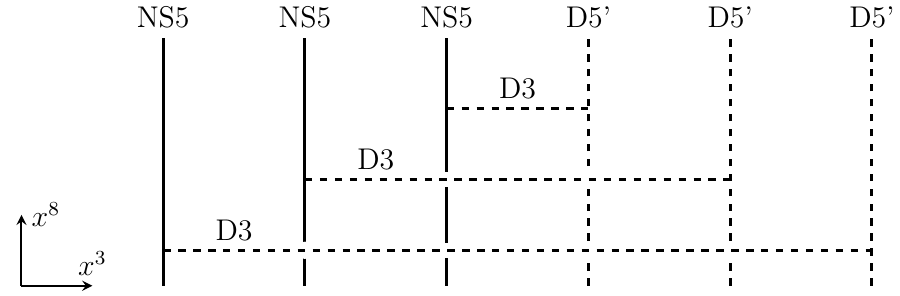
Figure 2 . The brane setup giving rise to the 3 d FT [SU(3)] gauge theory. Notice that the NS5 and D5’ branes form a ( p; q )-brane web in the directions (4 ; 9) (not shown) and coincide in the directions (7 ; 8) ( x 8 is vertical in the picture).